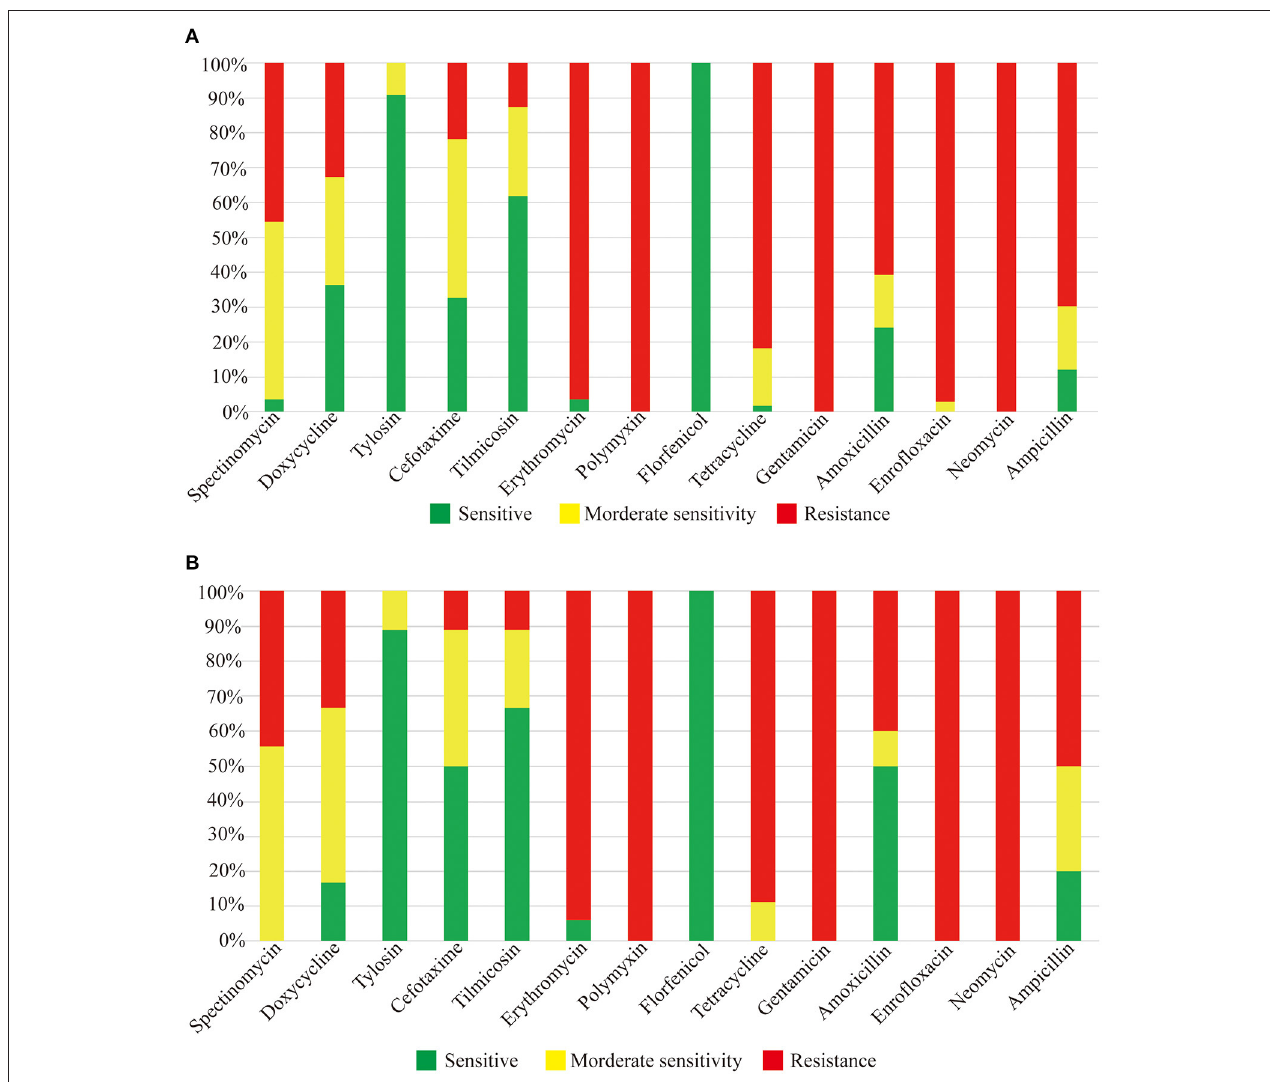
FIGURE 4 | Drug sensitivity test results. (A) Drug sensitivity results of serotype 15 R. anatipestifer strains. (B) Drug sensitivity results of other serotype